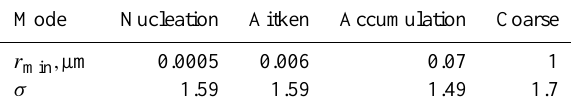
Table 2. Parameters of the aerosol size distribution in GMXe. Nucleation mode only for soluble particles.